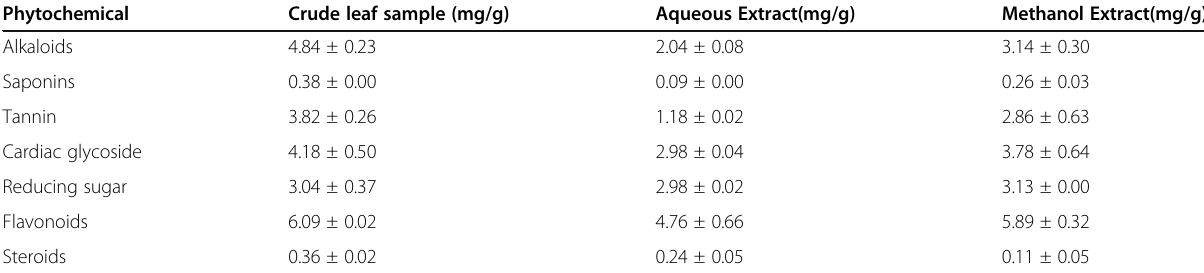
Table 3 Quantitative phytochemical screening of Dennettia tripetala leaves crude sample and extracts